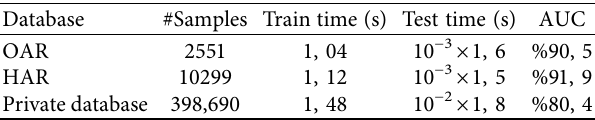
Table 2: Running times and AUC of databases using a hybrid system.